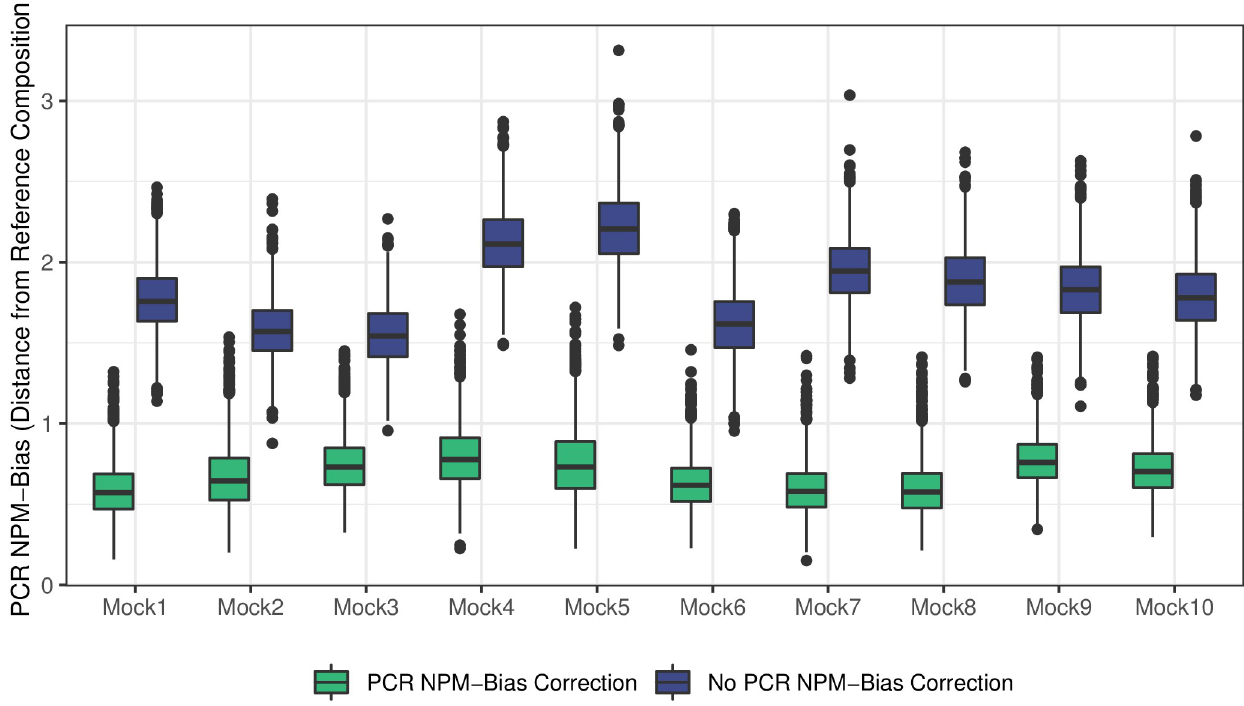
Fig 2. Combining calibration experiments with linear models allows PCR NPM-bias to be mitigated. No bias correction (blue) indicates difference between reference community compositions and raw community composition measured after 35 cycles of PCR. PCR NPM-bias correction (green) indicates the difference (measured by Aitchison distance) to reference community values after PCR bias model applied. Posterior distributions are represented as box plots. PCR NPM-Bias was inferred jointly for four calibration curves each created from a different starting community (Materials and methods). Perfect removal of all PCR NPM-bias in mock community sequenced samples corresponds to a value of 0 on the vertical axis.